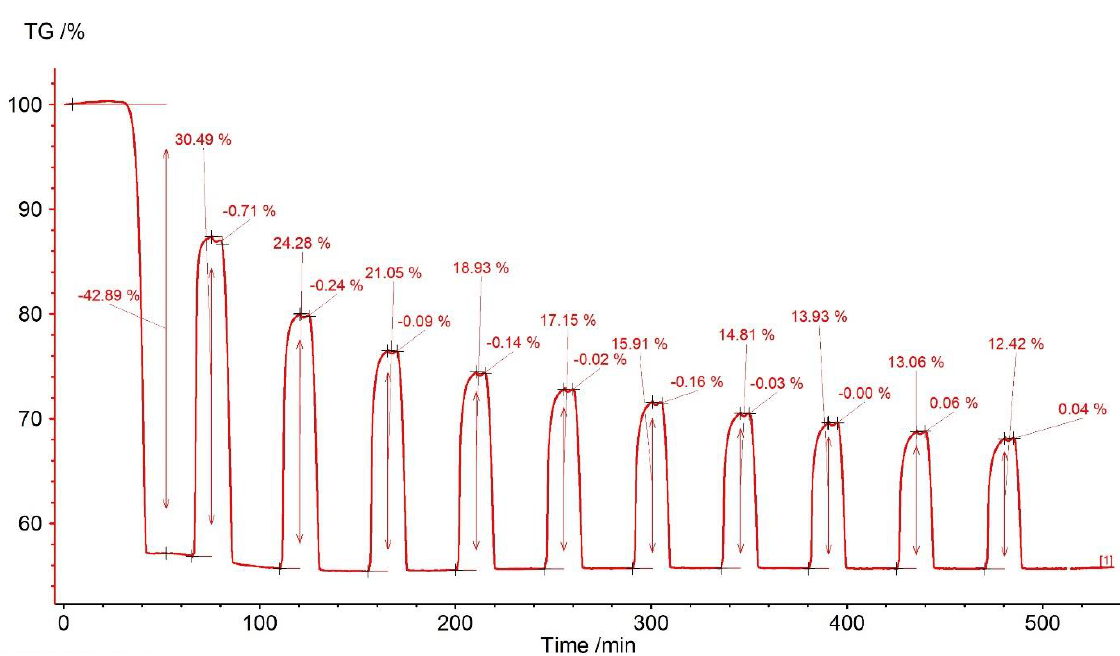
Figure 7. Relative mass changes for the limestone from Saint Anne Mountain.